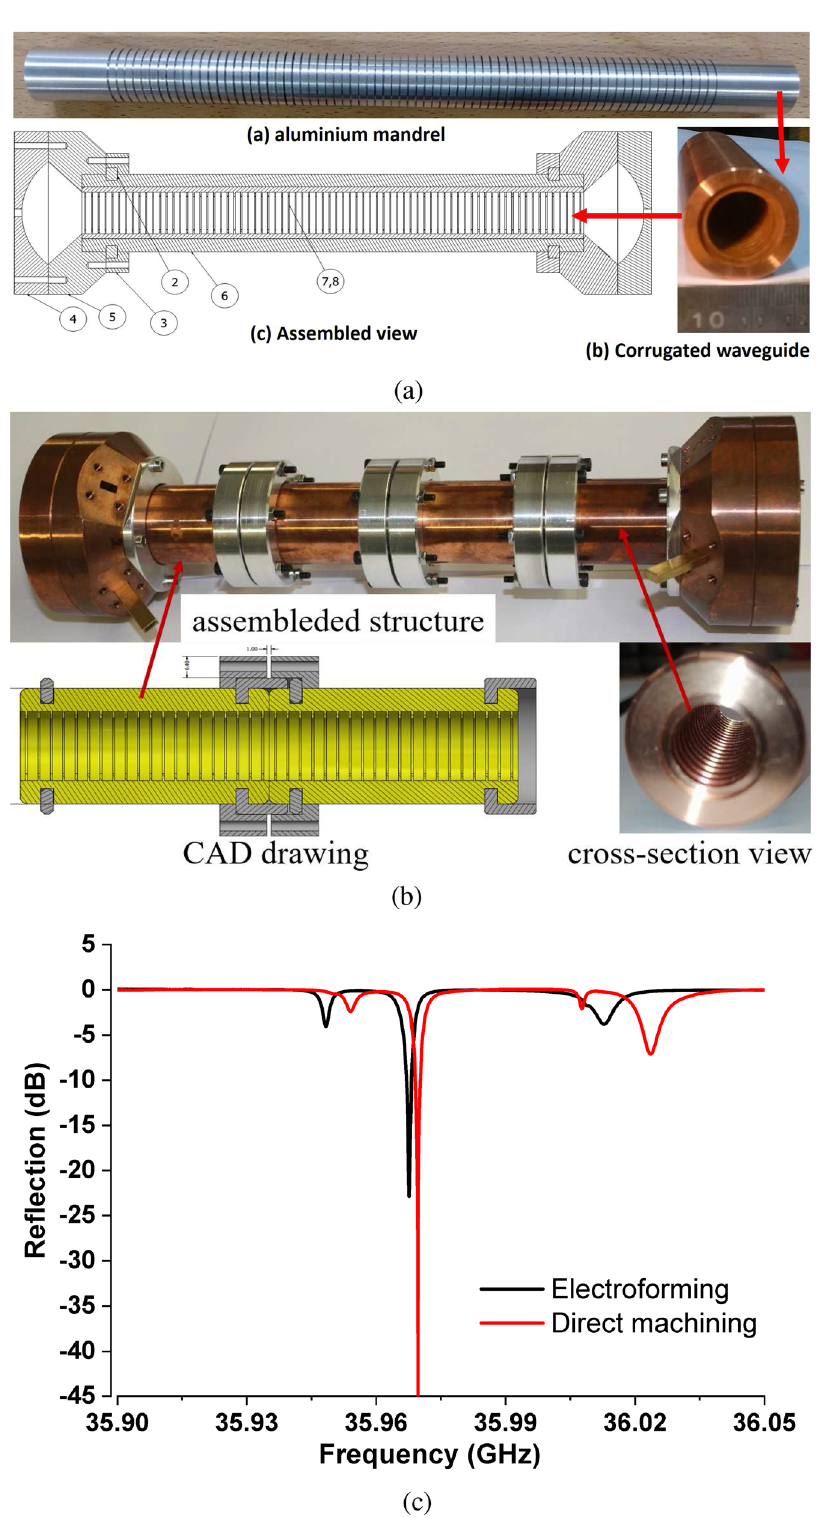
Figure 3. Machined structures of the Ka-band MU by ( a ) electroforming, ( b ) direct machining, and ( c ) the measurement